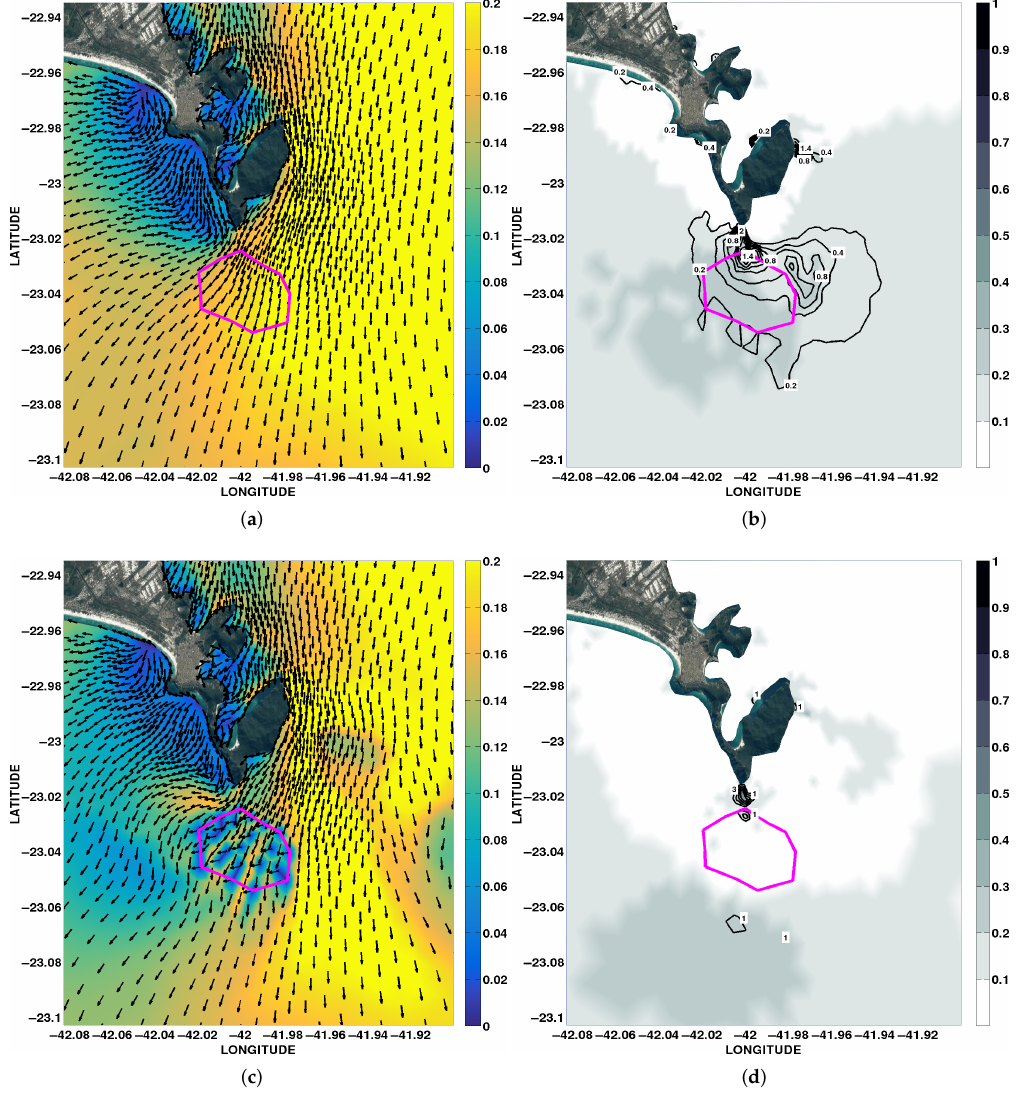
Figure 8. Rio de Janeiro turbines site. Simulation without the presence of turbines (upper panel) and with the turbines (lower panel), as the sites are represented by the magenta boundary line. ( a , c ) Mean superficial velocity (m · s − 1 ) with mean direction in vectors; ( b , d ) bed shear stress (N · m − 2 ) in black and white colormap with integrated bedload transport (cm 2 · s − 1 ) in black